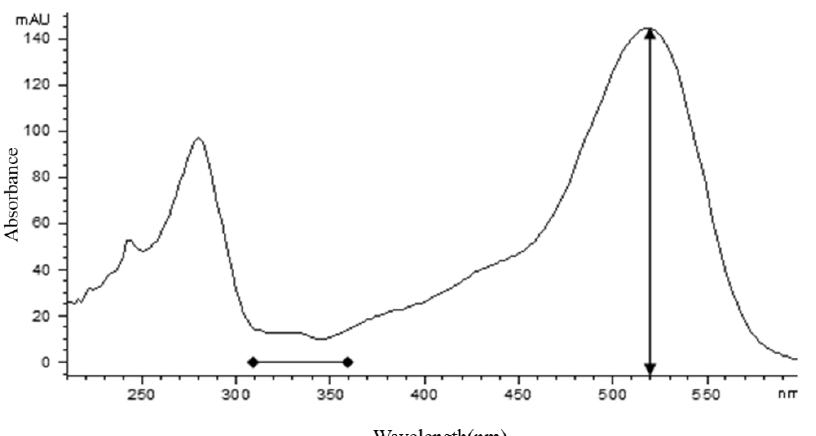
Figure 2. UV-Vis spectrum of the primary peak. The maximum absorbance at 520 nm. The lack of absorbance in the region between 310 and 360 nm (horizontal bar) indicates that the compound might not be acylated.